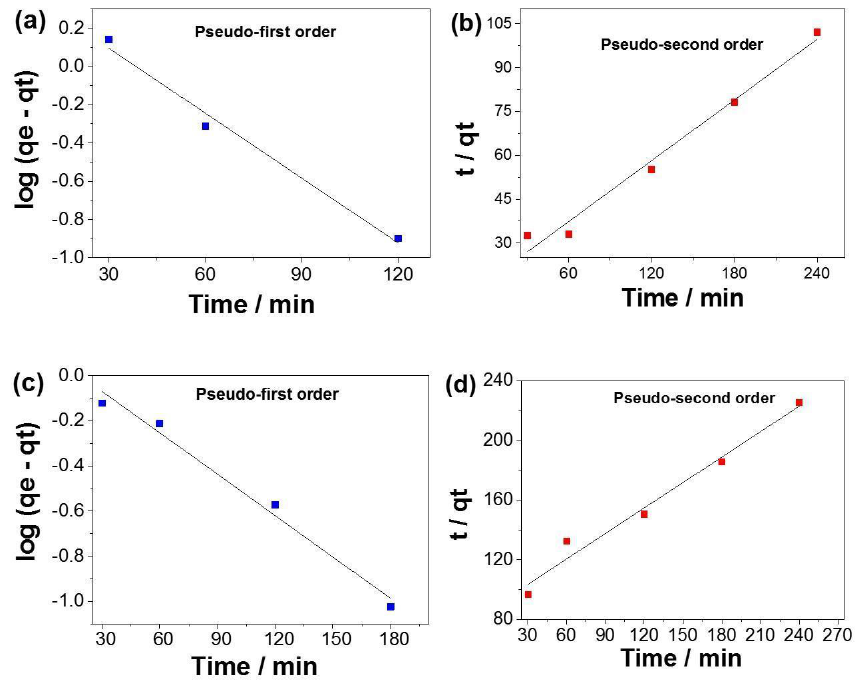
Figure 12. Kinetic assays of RhB dye adsorption ( a , b ) PLA:SiO 2 SGSil and ( c , d ) PLA:SiO 2 RHSil. Table 2. Kinetic parameters of RhB dye adsorption from pseudo-first-order and pseudo-second-or- der models.